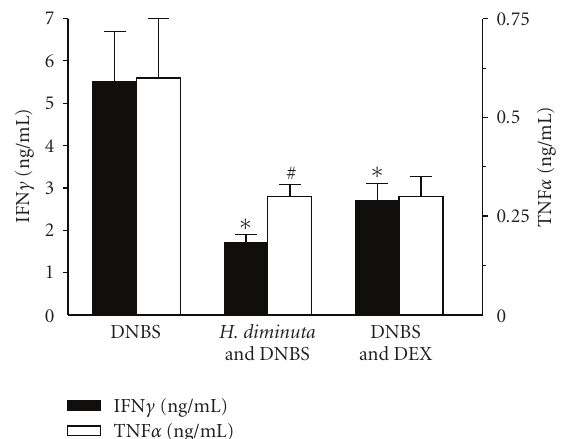
Figure 3: Bar graph showing concanavalin A (2 μ g/mL)-stimulated cytokine production from spleen cells (5 × 10 6 ), excised from mice 72hours post-DNBS treatment (mean ± SEM; n = 4-5 mice from 2 experiments; ∗ P < . 05 compared to DNBS only treated mice; # P = . 08 compared to DNBS only; DEX: dexamethasone).